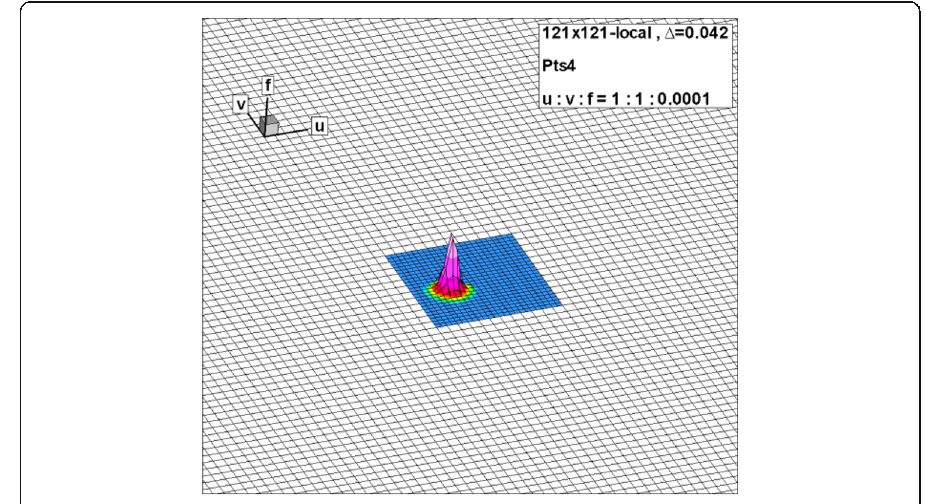
Fig. 2 Distribution function at pts4